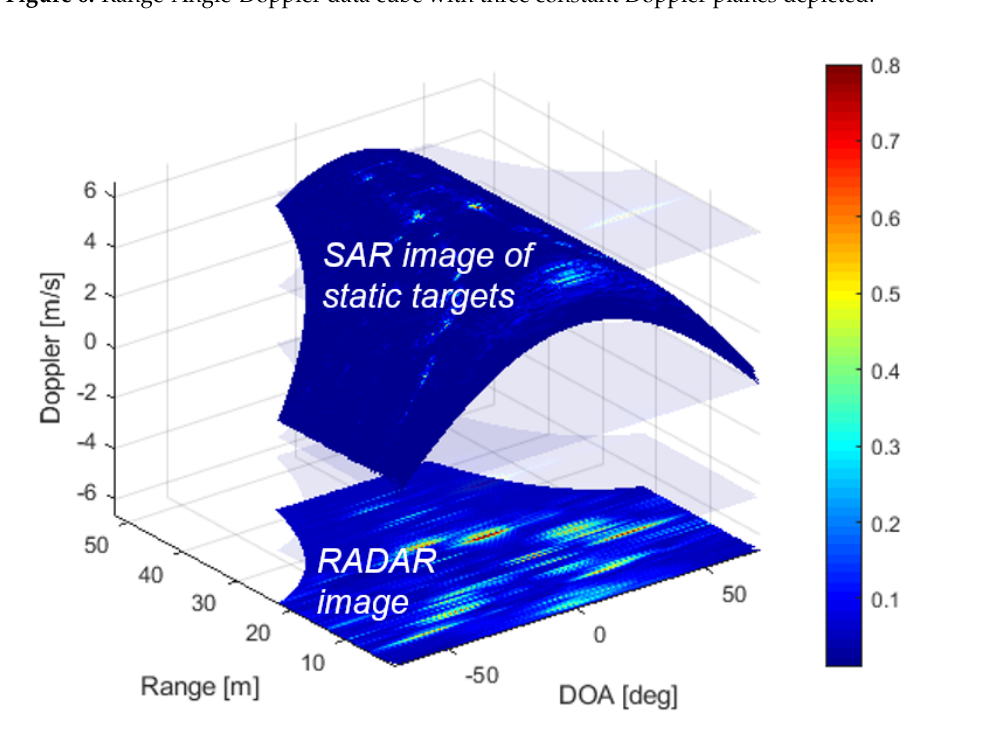
Figure 7. On the bottom of the plot, the radar image is computed by detecting the maximum Doppler for each range-angle bin. The SAR image can be interpreted as an intersection of the 3D RAV cube with a 2D